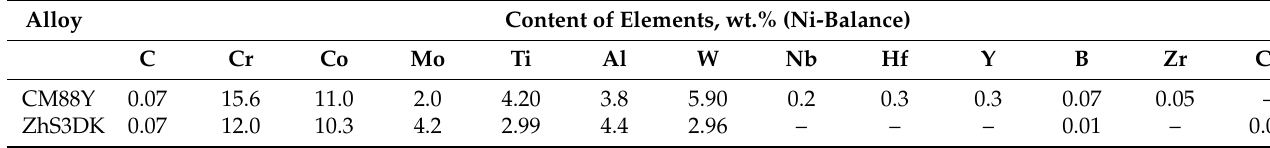
Table 2. Chemical composition of the investigated nickel superalloys.